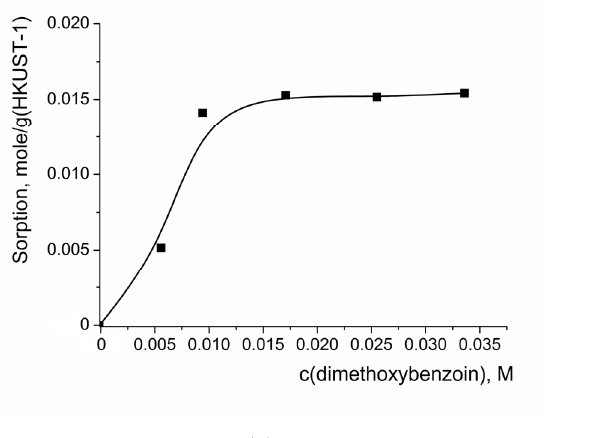
Figure 12. Comparison of the average initial rate ( a ) and the conversions after 3 h of reaction ( b ) in the reactions of benzoin and substituted benzoin oxidation by hydrogen peroxide without catalyst and in the presence of HKUST-1 (sum of catalytic and non-catalytic reactions). c(benzoin) = 0.033 M, c eff .( HKUST-1) and c(H 2 O 2 ) are shown in the graph.